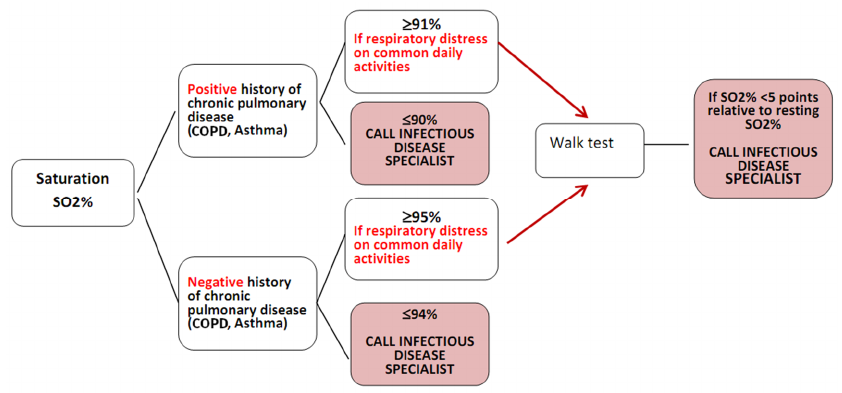
Figure 3. Decision-making algorithm for seeking infectious disease consultation. COPD = chronic obstructive pulmonary disease.